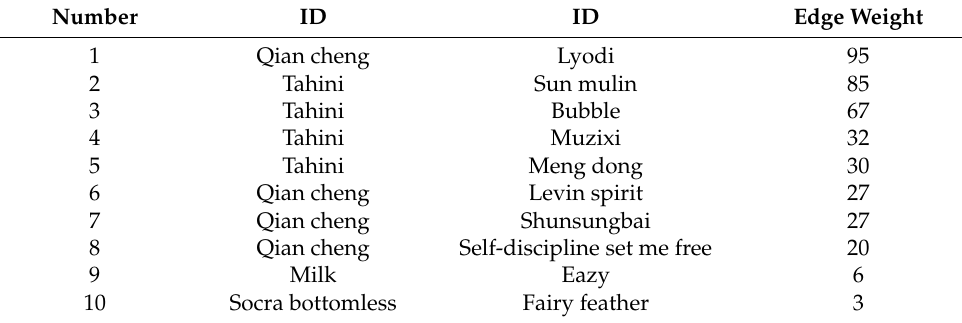
Table 2. Statistics of edge weight in the user relationship graph.